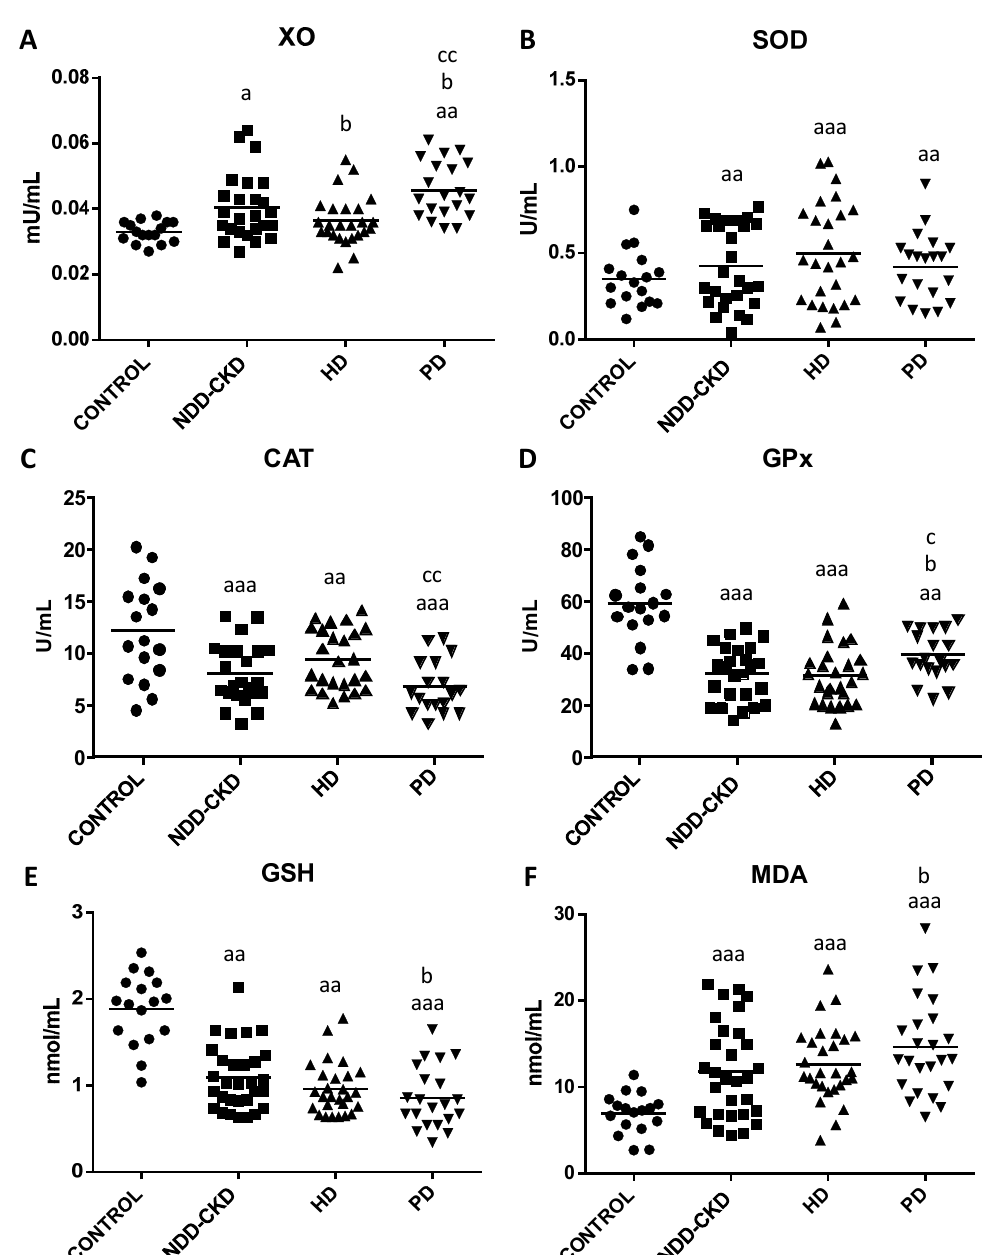
Figure 1. Oxidative stress and lipid damage parameters in plasma from healthy subjects (control), non-dialysis-dependent chronic kidney disease (NDD-CKD), hemodialysis (HD) and peritoneal dialysis (PD) patients. ( A ) Xanthine oxidase (XO; mU/mL), ( B ) superoxide dismutase (SOD; U/mL), ( C ) catalase (CAT; U/mL) and ( D ) glutathione peroxidase (GPx; U/mL) activities; ( E ) reduced glutathione (GSH; nmol/mL) and ( F ) malondialdehyde (MDA; nmol/mL) contents. Data are shown as the mean (horizontal bar) of 17–39 values corresponding to the number of subjects analyzed in each group. Each value is the mean of duplicate assays. a p < 0.05, aa p < 0.01 and aaa p < 0.001 versus control; b p < 0.05 versus NDD-CKD patients; c p < 0.05 and cc p < 0.01 versus HD patients.